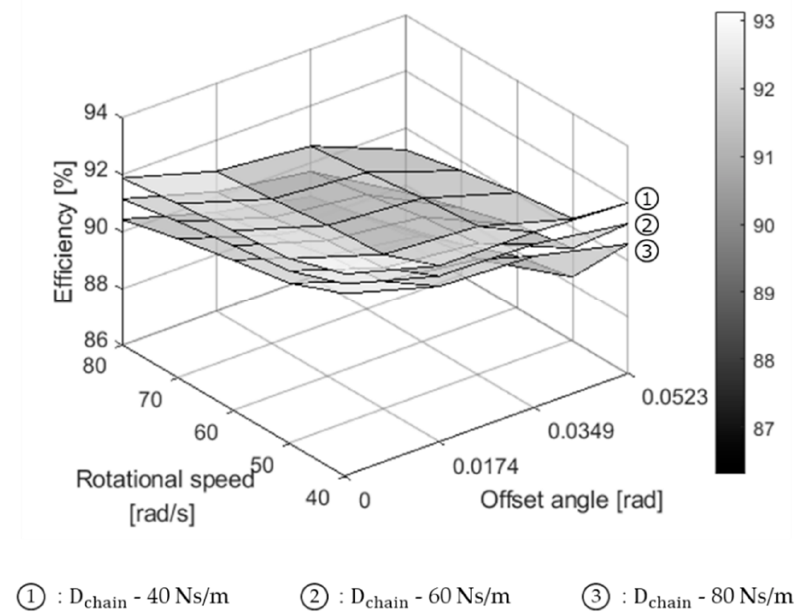
Figure 6. Transmission efficiency as a function of rotational speed, offset angle, and damping coefficient.